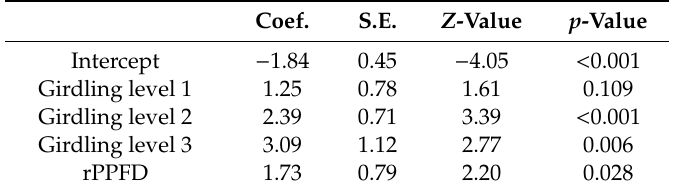
Table 1. Summary of generalized linear mixed-e ff ect model for estimating the probability of reproduction in Japanese larch. Relative photosynthetic photon flux density (rPPFD) was used as a fixed-e ff ect covariate, while the e ff ect of girdling treatment was used as a fixed-e ff ect main factor. Coef. S.E. Z Treatment Level3